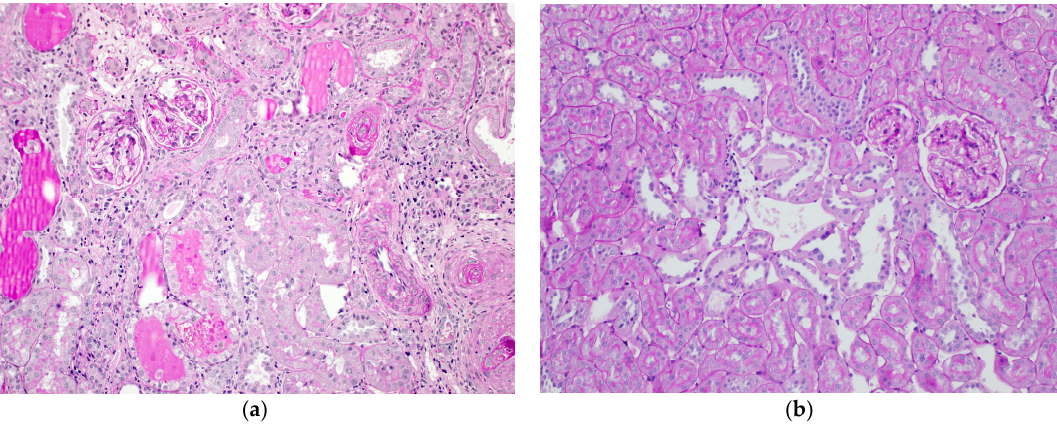
Figure 1. Pathological changes of renal cortical sections in spontaneously hypertensive rats ( a ) and normotensive Wistar Kyoto rats ( b ) after 8%-salt loading for eight weeks. periodic acid-Schiff stain. Original Magnification 200×. Original Image.